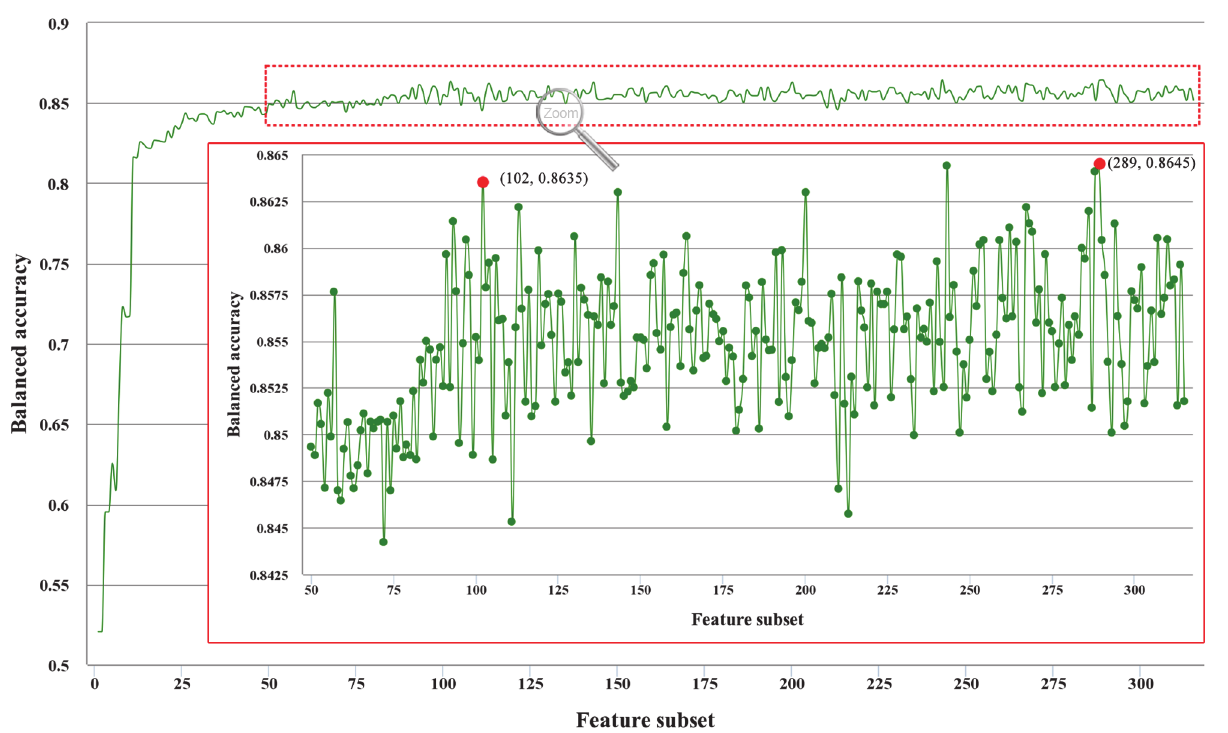
Fig 2. The IFS(Incremental Feature Selection) curve: the values of balanced accuracy against the feature subset. By adding features one by one from higher to lower rank, 315 different feature subsets are obtained. The individual predictor is then accordingly built for each feature subset and evaluated by 10- fold cross-validation. The IFS curve reveals the relation between the balanced accuracy ( BAcc ) and the feature subset.